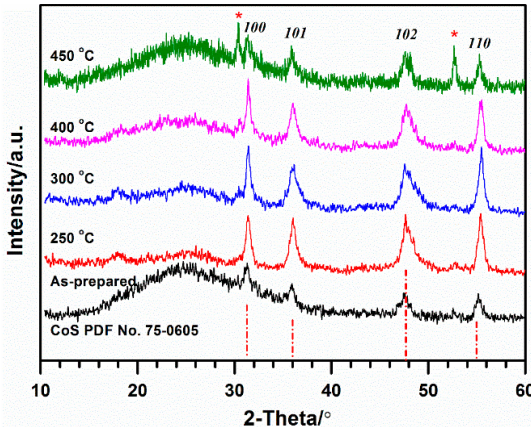
Figure 1. Powder X-ray diffraction patterns of the as-prepared 20 wt. % CoS/C sample and four annealed samples at four different temperatures: CoS-250, -300, -400 and -450, respectively. Vertical dot-dashed lines represent the ICDD-PDF2-2004 card of CoS